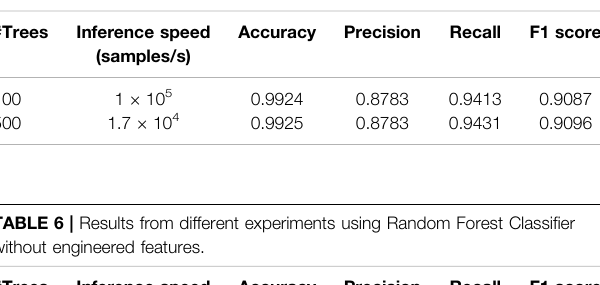
TABLE 7 | Most important features when using the whole time series as input to the RFmodel without engineered